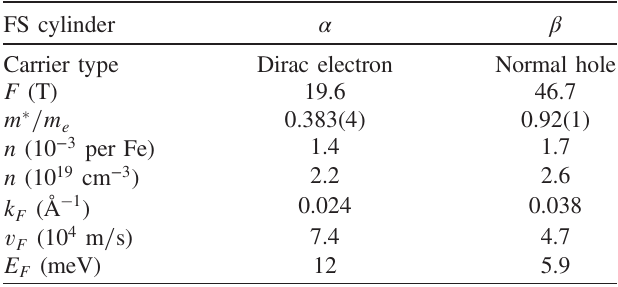
TABLE I. Carrier type, quantum-oscillation frequency F , ef- fective mass m (cid:2) , carrier density n , Fermi momentum k velocity v , and effective Fermi energy E F quantum-oscillation measurements. B ∥ c for F and m (cid:2) . n for the α cylinder refers to the sum of the carriers of the two cylinders occurring in the Brillouin zone. To derive E ¼ ℏ v k ( E ) was used for the α cylinder, while a quadratic one F F F ¼ ℏ 2 k 2 = ð 2 m (cid:2) Þ ] was used for β [ E F F